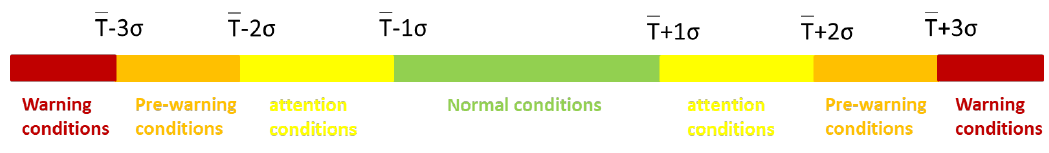
Figure 5 thresholds setting method of temperature